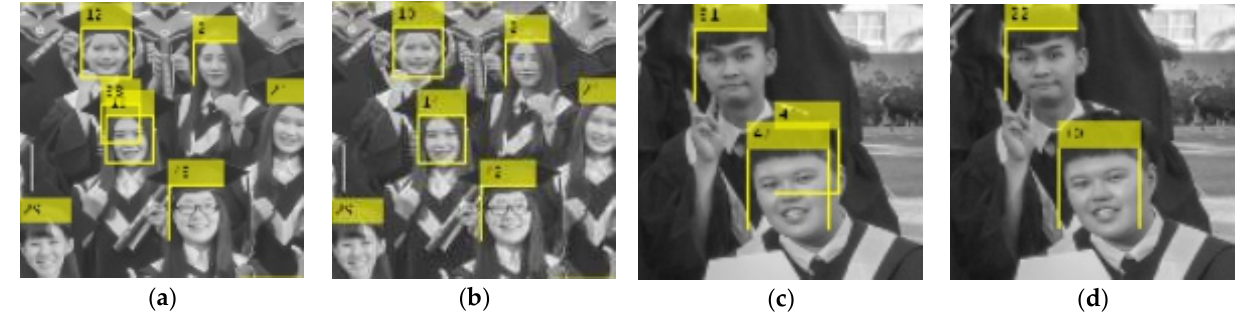
Figure 5. Examples of repetition removal for human face detection: ( a ) detection with repetition error for photo 1; ( b ) removal of repetition error for photo 1; ( c ) detection with repetition error for photo 2; ( d ) removal of repetition error for photo 2.